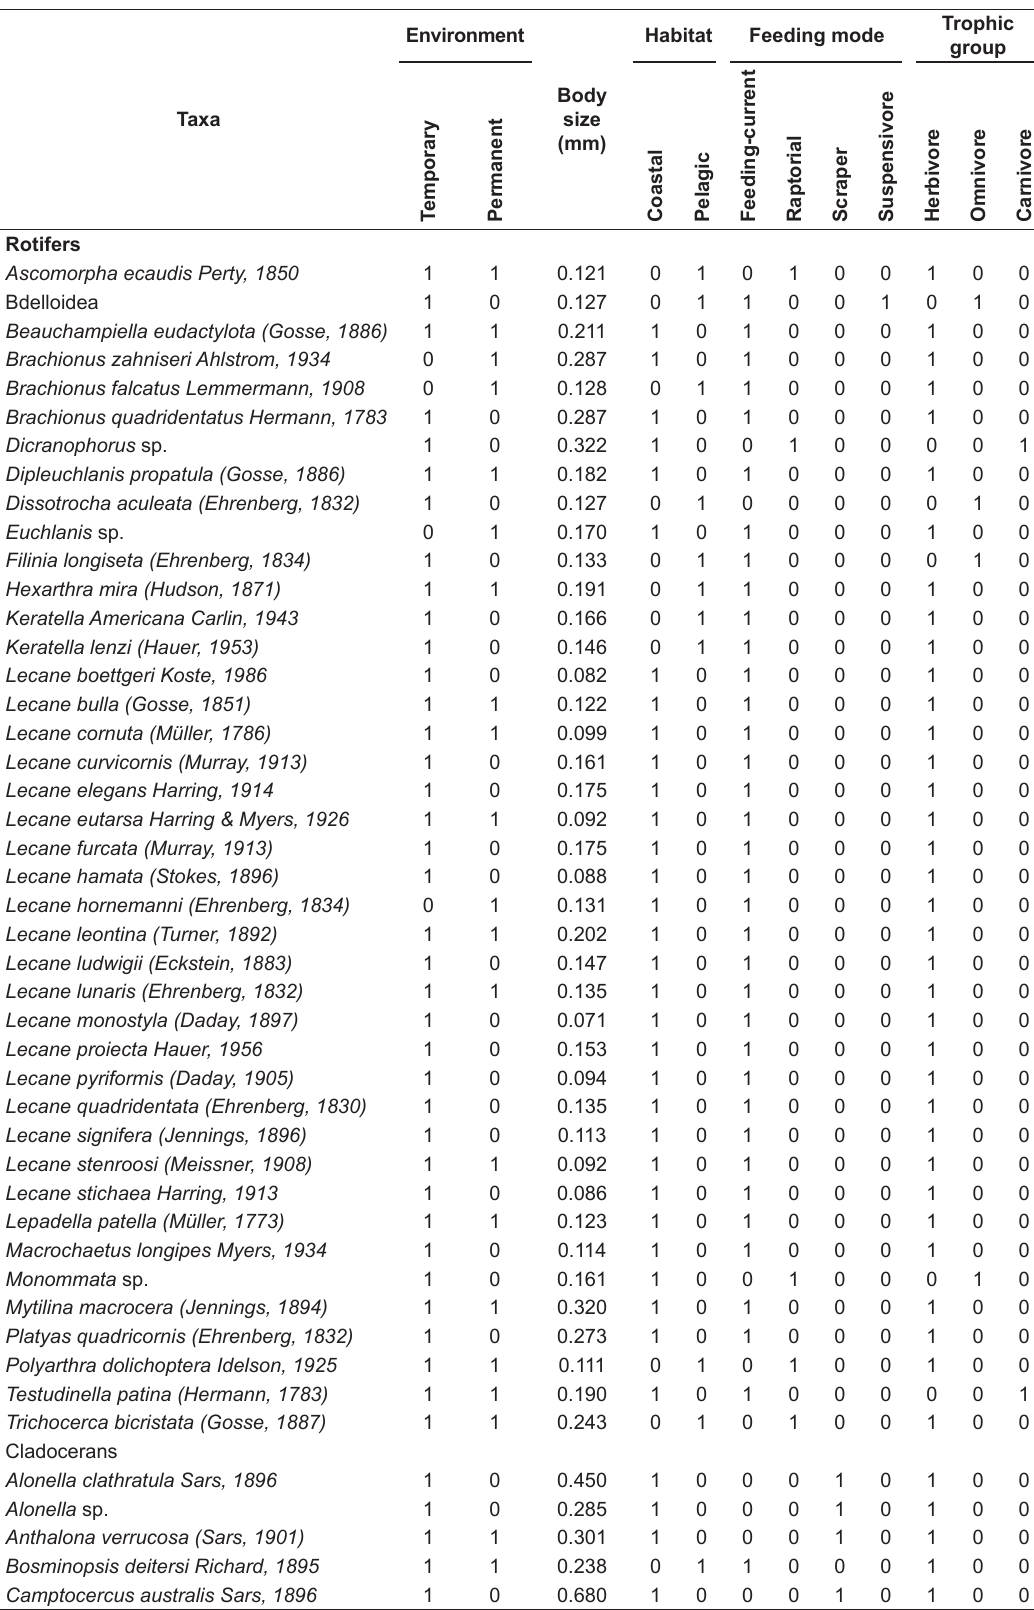
Table 3. Zooplankton species and their functional traits found in 5 temporary ponds and 5 permanent lagoons located in Restinga de Jurubatiba National Park, Rio de Janeiro, Brazil. Samples were taken in 6 and 20 April and 13 May 2010.